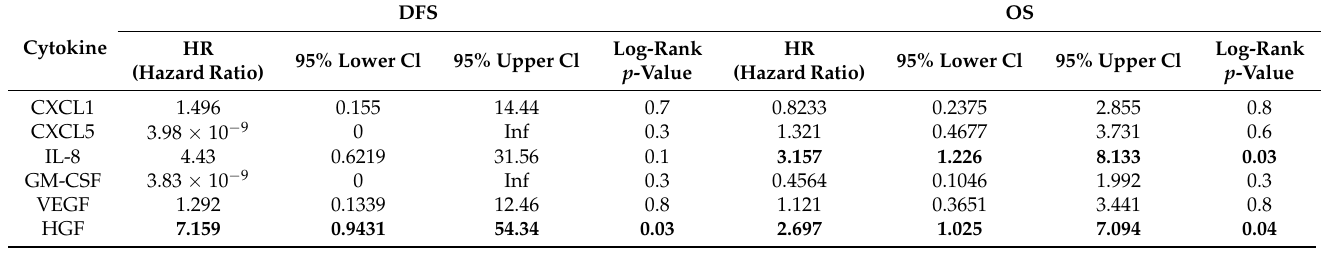
Table 2. Hazard ratios (HR) of disease recurrence (DFS) or death (OS) in breast cancer patients from TCGA database focused on the analysis of cytokines overexpressed by ER α 36 high CAFs. Significant results are bolded.